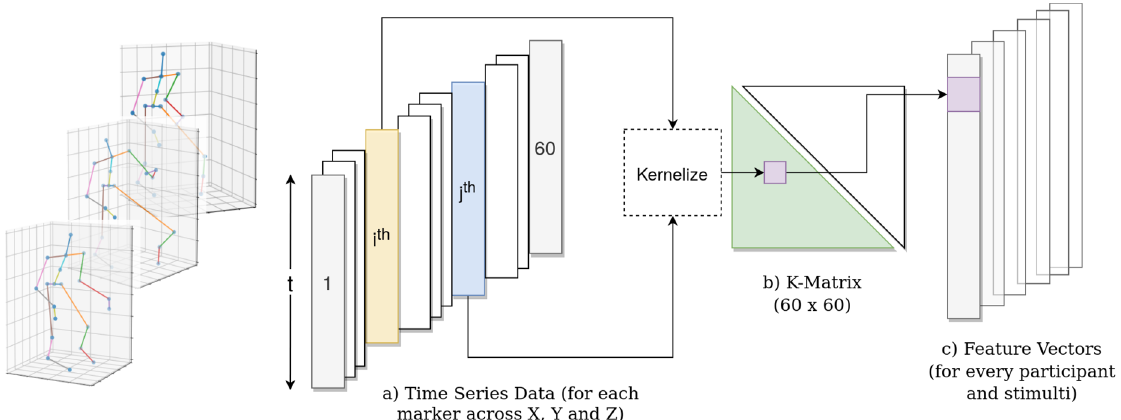
Figure 9. Overview of our feature extraction pipeline. Given the position of joints across time frames in 3D Euclidean space ( a ), we apply pairwise correntropy between time series x i and x j and calculate the K-matrix ( b ). Then, taking the lower triangular part of the symmetric covariance matrix, we get the feature vectors ( c